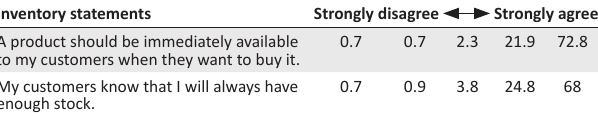
TABLE 5: Respondents’ level of agreement with the inventory statements.